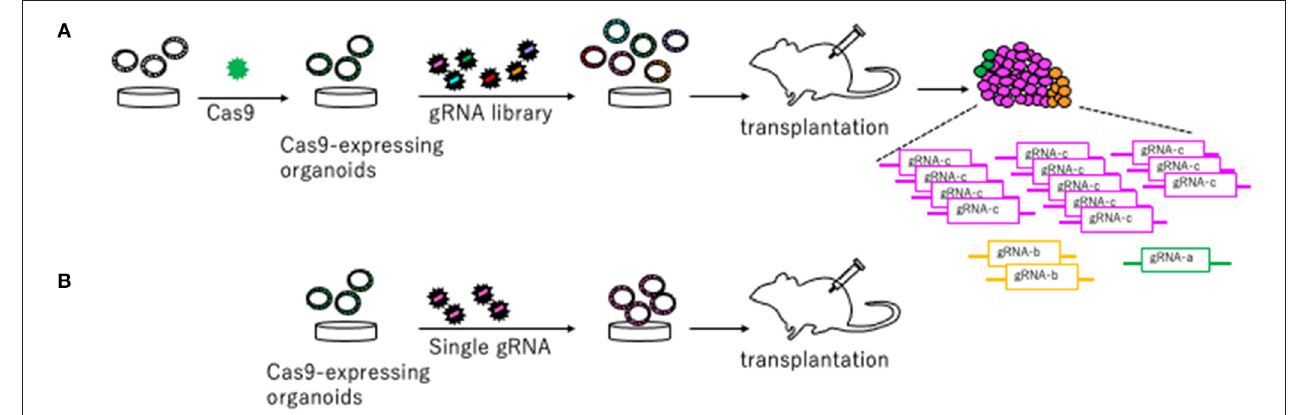
FIGURE 2 | A platform to validate candidate tumor suppressor genes using CRISPR-Cas9 in mouse organoids described in Takeda et al. (2019). (A) Cas9 is introduced to organoids to generate Cas9-expressing organoids. The gRNA library targeting candidate tumor suppressor genes are generated and introduced to Cas9-expressing organoids. Organoids carrying the gRNA library are transplanted to mice to induce tumors. The gRNAs over-represented in the tumor tissue compared to pre-injected organoids are likely to be tumor suppressors. (B) Further individual validation by introducing a single gRNA targeting a gene in Cas9-expressing organoids and subsequent transplantation makes it possible to confirm a tumor suppressive function of a driver